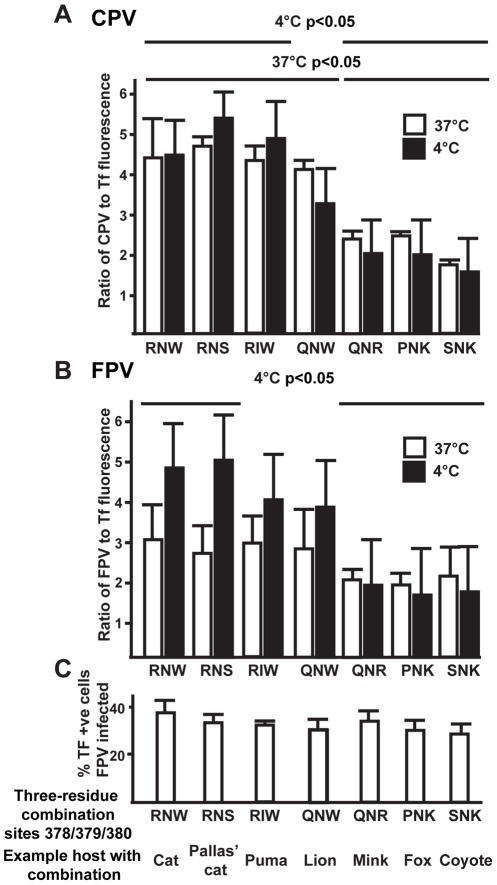
Determining the effects of varying residues in the feline TfR apical domain on parvovirus binding.CPV (A) or FPV (B) and Tf were incubated with TRVb cells expressing receptors with different combinations of the residues 378, 379, and 380 (feline TfR numbering). The name of one host species which contains the combination of residues shown is also given. Ligands were incubated with the cells at 37°C (white) or 4°C (black). Fluorescence of the labeled capsid was divided by fluorescence of the bound Tf to account for differential receptor expression. The mean of this ratio among all receptor-expressing cells was evaluated for each of three trials. The mean and standard deviation of the three trials is shown. Brackets connect groups of receptors that were statistically different in pairwise comparisons by Tukey's HSD at α = 0.05; i.e. samples not covered by a bracket did not differ at the α = 0.05 level in any comparisons. C) Effects of variant residues in the feline TfR on FPV infection. Cells expressing exogenous TfR with different three-amino acid combinations at residues 378–380 were inoculated and the ratio of infected cells (expressing NS1) and those expressing TfR is shown. The expressed receptors were compared for infection percentage by fitting a generalized linear mixed model to the binomial data and considering replication as a random effect, and those differed at the p = 0.034 level. Only one pairwise comparison was statistically significant after controlling for multiple testing by the Tukey-Kramer method: 34% of cells expressing TfR containing QNR (as seen in the mink TfR) were infected by FPV, while 26% of cells containing RNS (as Pallas' cat) were infected.